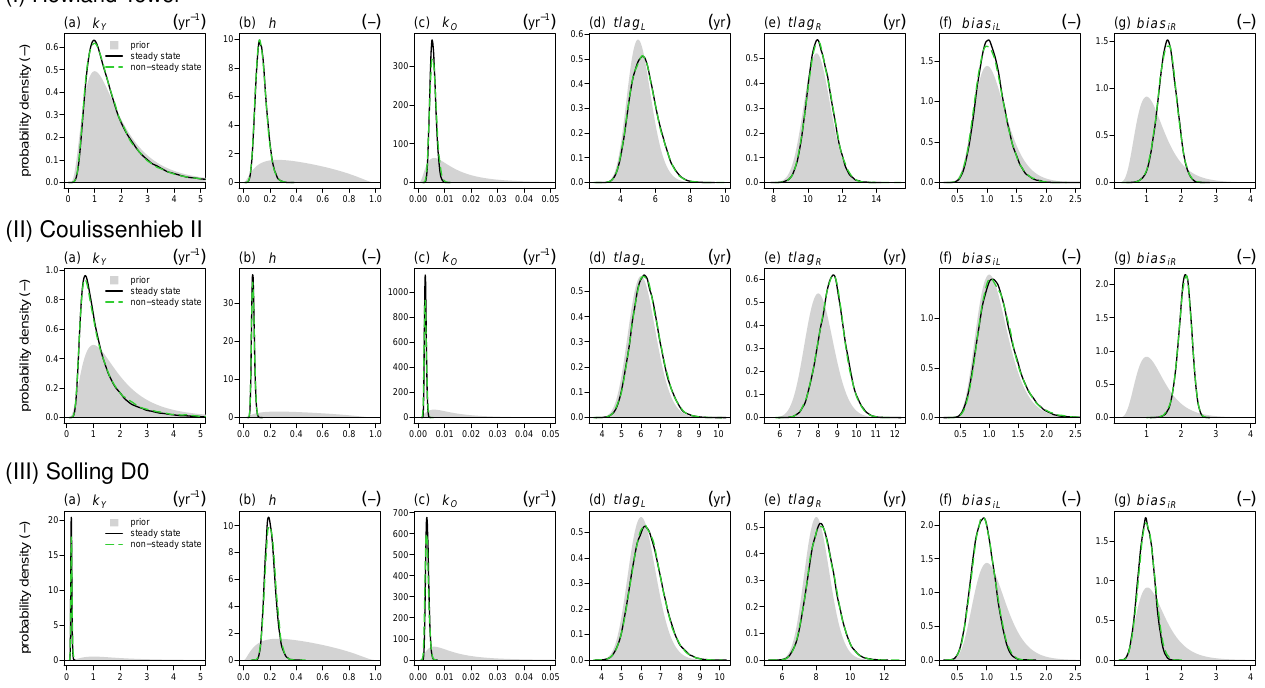
Fig. 8. Comparison of posterior parameter distributions of the all-observational-constraints run, Run(+HR), under steady-state assumption (solid black line) and under a relaxed steady-state assumption (dashed green line). The additional parameters f Y and f O for the nonsteady- state run are not